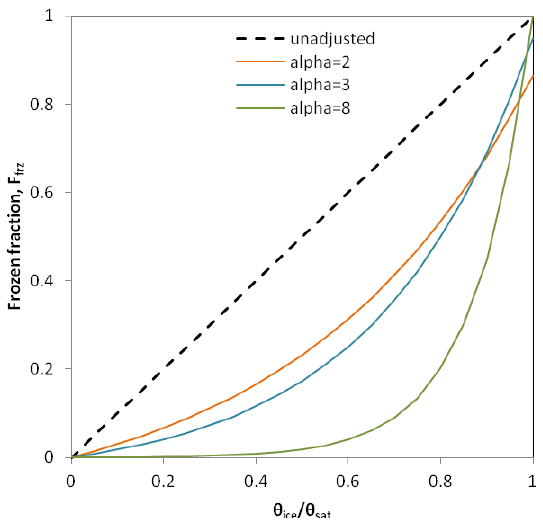
Fig. 2. Demonstrating the effect of f on the F sat function. The max- imum surface saturation value has been set to an approximate value of 0.3, mean water table depth has been set to 1m, and α set to its chosen model value of 3.0. The blue line uses the chosen model pa- rameter while the orange and green lines use parameters that lie just outside the extremes of the selected parameter space.